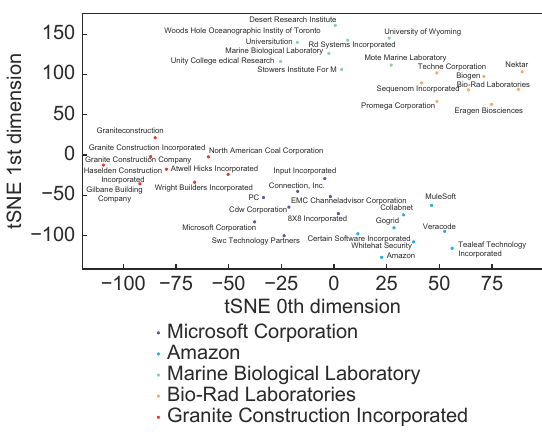
Fig. 4 Clustering of similar industrial